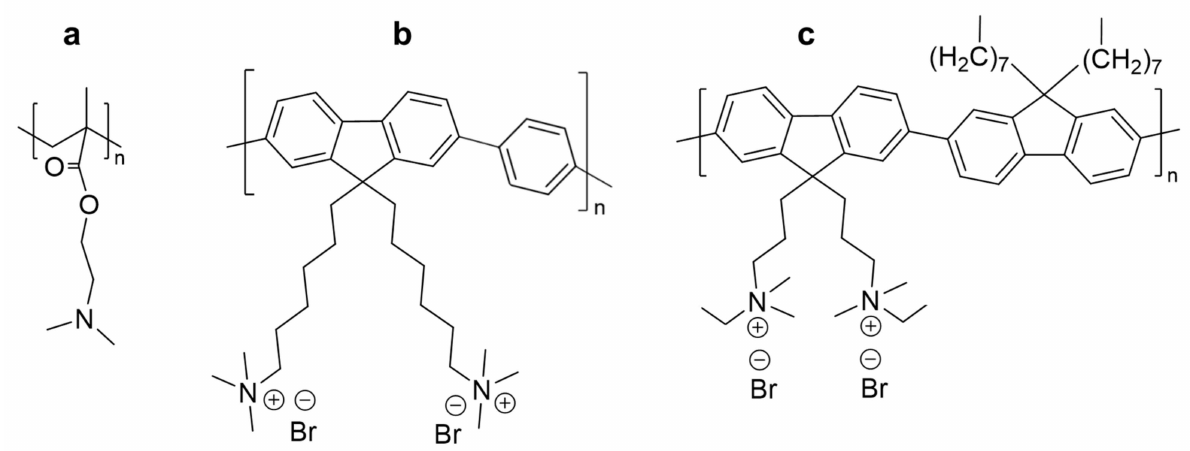
Figure 1. Chemical structures of the responsive polymers involved in formulations for functionalizing paper: ( a ) poly(2-(dimethylamino)ethyl methacrylate)—polyDMAEMA; ( b ) poly(9,9-bis(6 (cid:48) - N , N , N - trimethylammonium)hexyl)-fluorene phenylene) bromide—HTMA-PFP; ( c ) poly(9,9-bis(3 (cid:48) -( N , N - dimethyl)- N -ethylammoinium-propyl-2,7-fluorene)-alt-2,7-(9,9-dioctylfluorene))dibromide— PEDMA-DO-PBF.